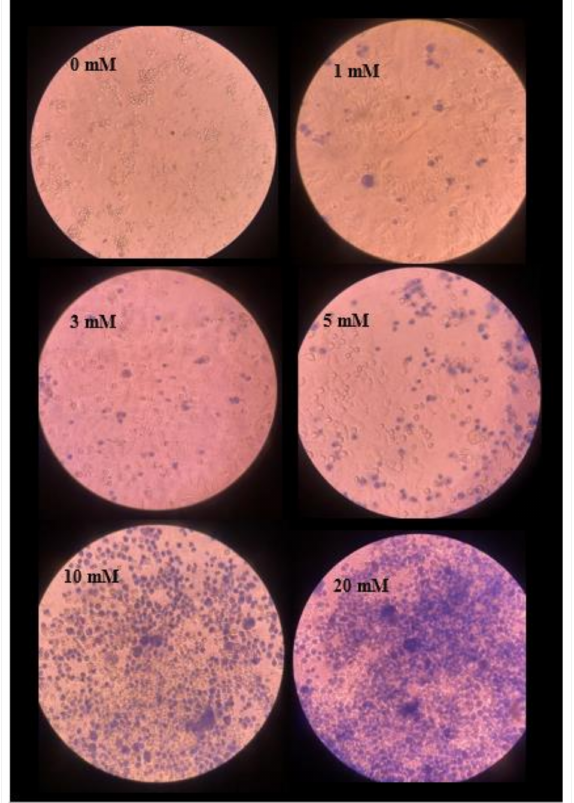
Figure 9. Results of cell viability in various concentration of